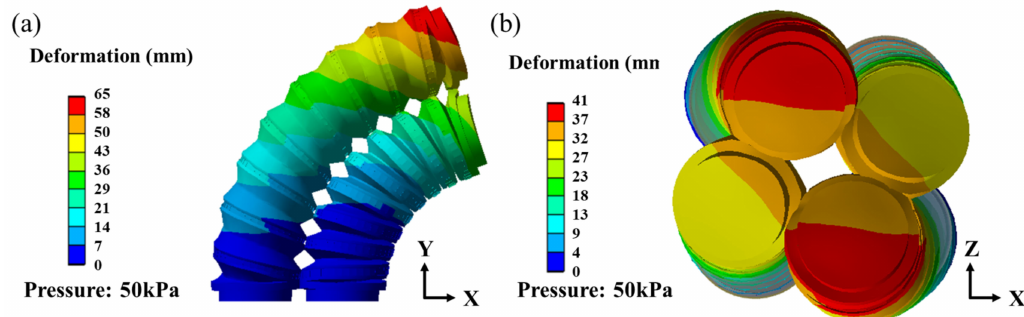
Figure 5. Soft wrist motion simulation: ( a ) bending right; ( b ) twisting